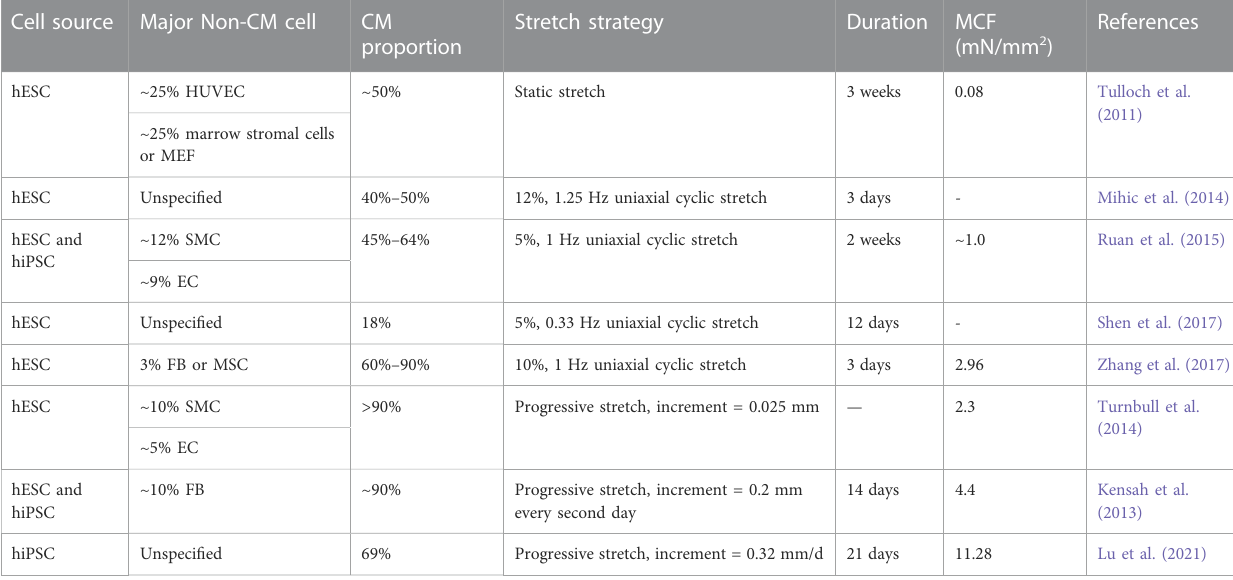
The percentage in the “ StretchStrategy ” column refers to thepercentage of deformationon the basisof theoriginal cell length. CM, cardiomyocyte;EC, endothelial cells;FB, fi broblast; hESC, human embryonic stem cell; hiPSC, human induced pluripotent stem cell; HUVEC, human umbilical vein endothelial cell; MCF, maximum contractile force; MEF, mouse embryonic fi broblasts; MSC, mesenchymal stem cell; SMC, smooth muscle